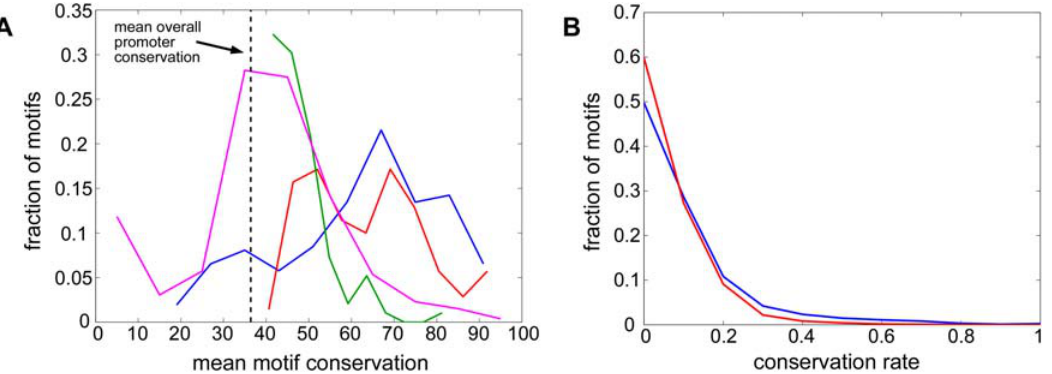
Figure 3. Evolutionary conservation of highly scoring k-mers. A. Evolutionary conservation in four Saccharomyces species [27] was calculated for the highly scoring S. cerevisiae cell cycle k-mers (lengths 7–11; shown in red) and compared with the conservation of two sets of motifs defined by yeast phylogenetic footprinting: Cliften et al. [27] (green) and Kellis et al. [28] (blue). A set of the randomized k-mers was used as a control (to preserve the same GC content) and is shown in magenta. For each putative motif, evolutionary conservation was calculated by finding the percentage of fully conserved (in all aligned species) positions in each motif instance, and averaging over all motif instances. The background promoter conservation was calculated in a similar manner by counting the number of fully conserved positions in each promoter and averaging over all promoters. The highly scoring k-mers are conserved comparably to the set of motifs published by Kellis et al. [28] and appear to be more conserved than the set published by Cliften et al. [27]. The randomized k-mers show an evolutionary conservation that is similar to that of the background promoters ( , 36%). B. Evolutionary conservation rate in four Saccharomyces species [27] was calculated for the motifs of the core dataset (blue) and compared with the evolutionary conservation rate of a control set of randomized k-mers (to preserve GC content), shown in red. For each putative motif, evolutionary conservation rate was calculated as the percentage of motif instances that are highly conserved (i.e. at least 90% of the motif positions were identical across all four species). The evolutionary conservation rates of the core dataset motifs tend to be higher than those of the control set (Wilcoxon-Cox ranksum test; p , 10 2 300 ).